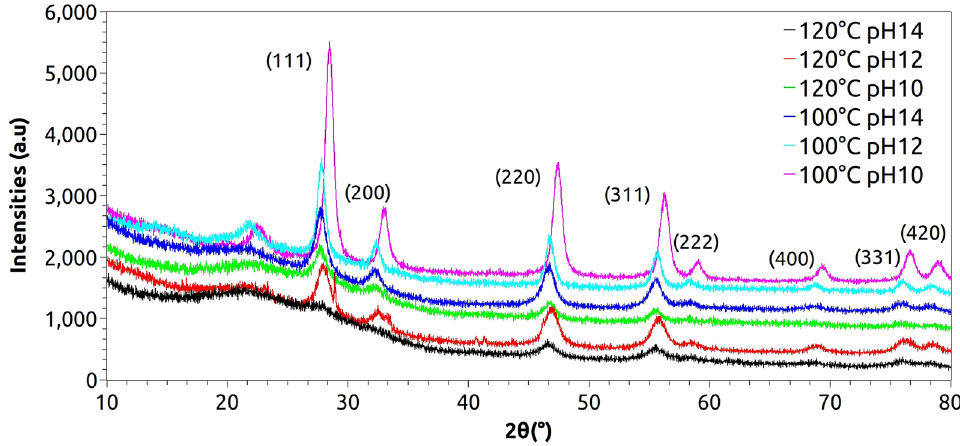
Figure 1. XRD patterns of the samples synthesized by microwave-assisted hydrothermal method at 100 and 120 °C with pH 10, 12 and 14.